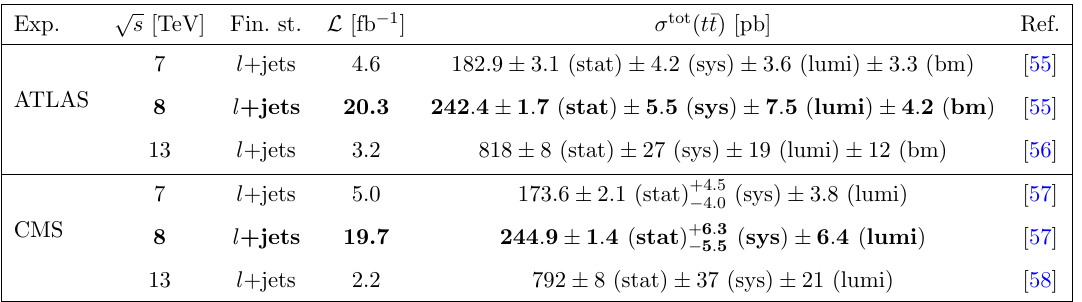
Table 2 . Summary of the most precise ATLAS and CMS measurements of the total inclusive t (cid:22) t cross-sections at 7, 8 and 13 TeV. We indicate the (cid:12)nal state, the integrated luminosity, the break- down of statistical and systematic uncertainties (where \lumi" stands for the luminosity and \bm" stands for the beam energy). The measurements in boldface are those used in the (cid:12)ts of this